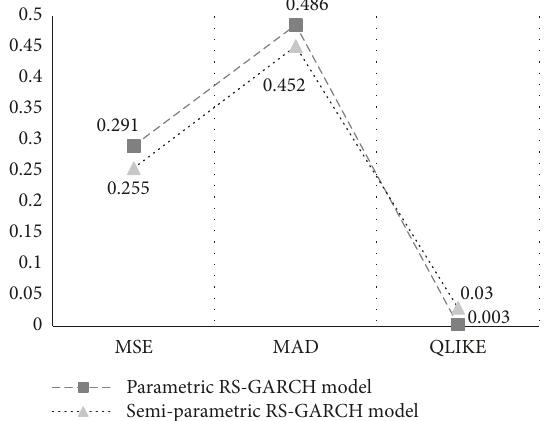
Figure 9: The model fitting error results out of sample period (CSI